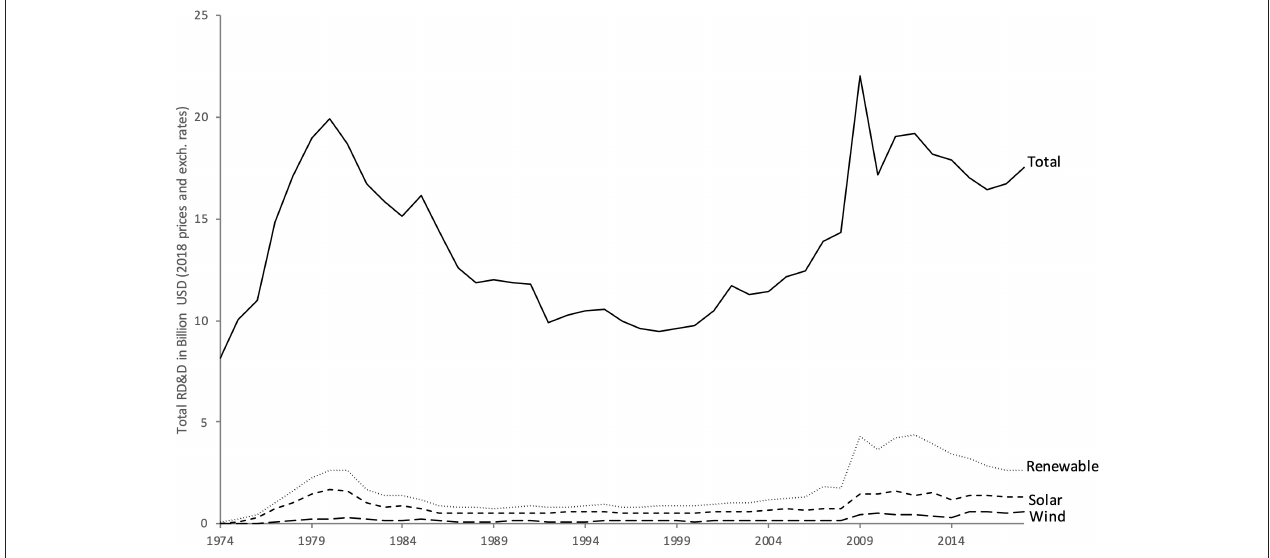
FIGURE 2 | Government research, development and demonstration (RD&D) investments in energy technologies for countries reported by the International Energy Agency. While ecosystems are explicitly noted within the investments for large hydropower, interactions between wind, solar, and the environment remain